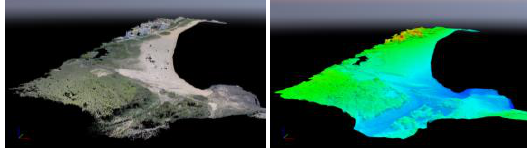
Figure 5. The mesh and DSM of Shanshui beach.